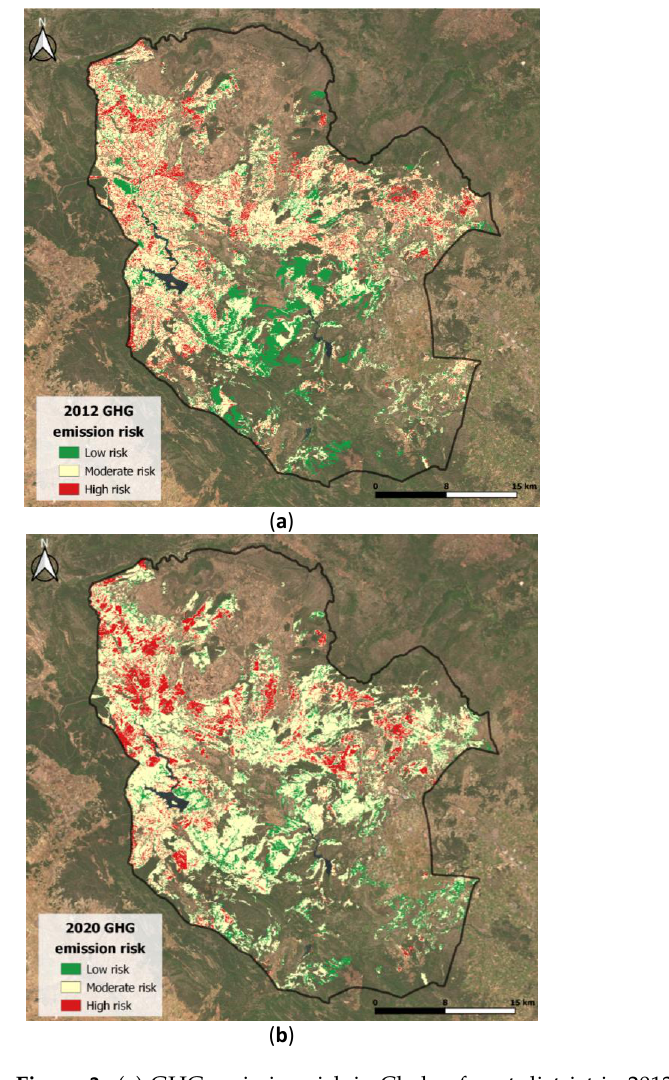
Figure 3. ( a ) GHG emission risk in Chelva forest district in 2012, previous to the fires. ( b ) GHG emission risk in Chelva’s forest district in 2020.